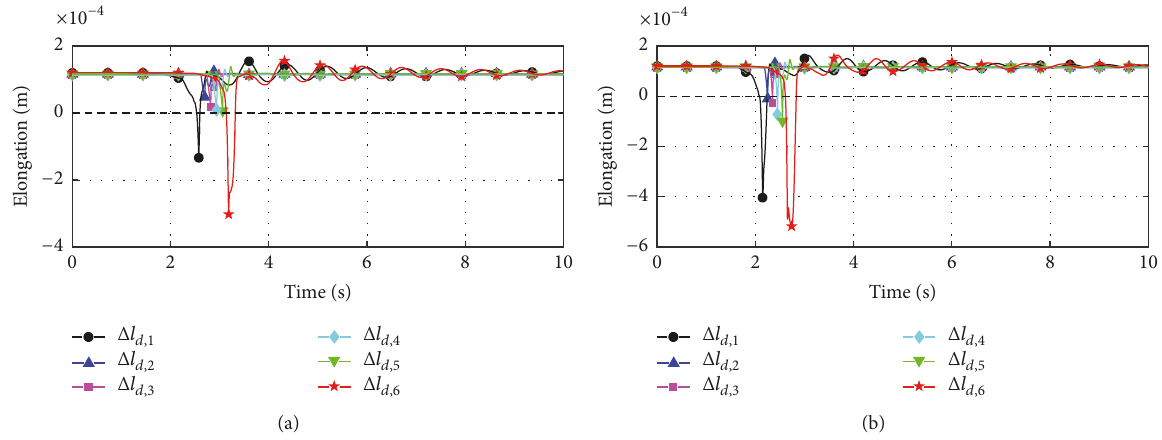
Figure 18: The slackening of the droppers in the simple stitched catenary when (a) 𝑉 = 250 km/h and (b) 𝑉 = 300 km/h.